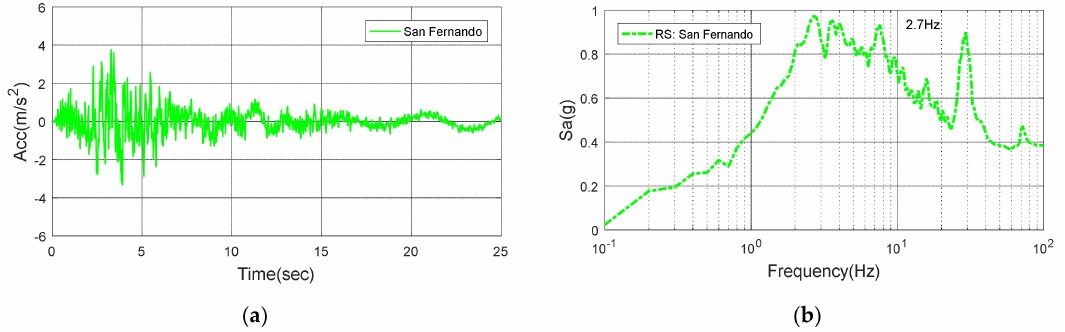
Figure 16. San Fernando: ( a ) Time history; ( b ) Response spectrum.